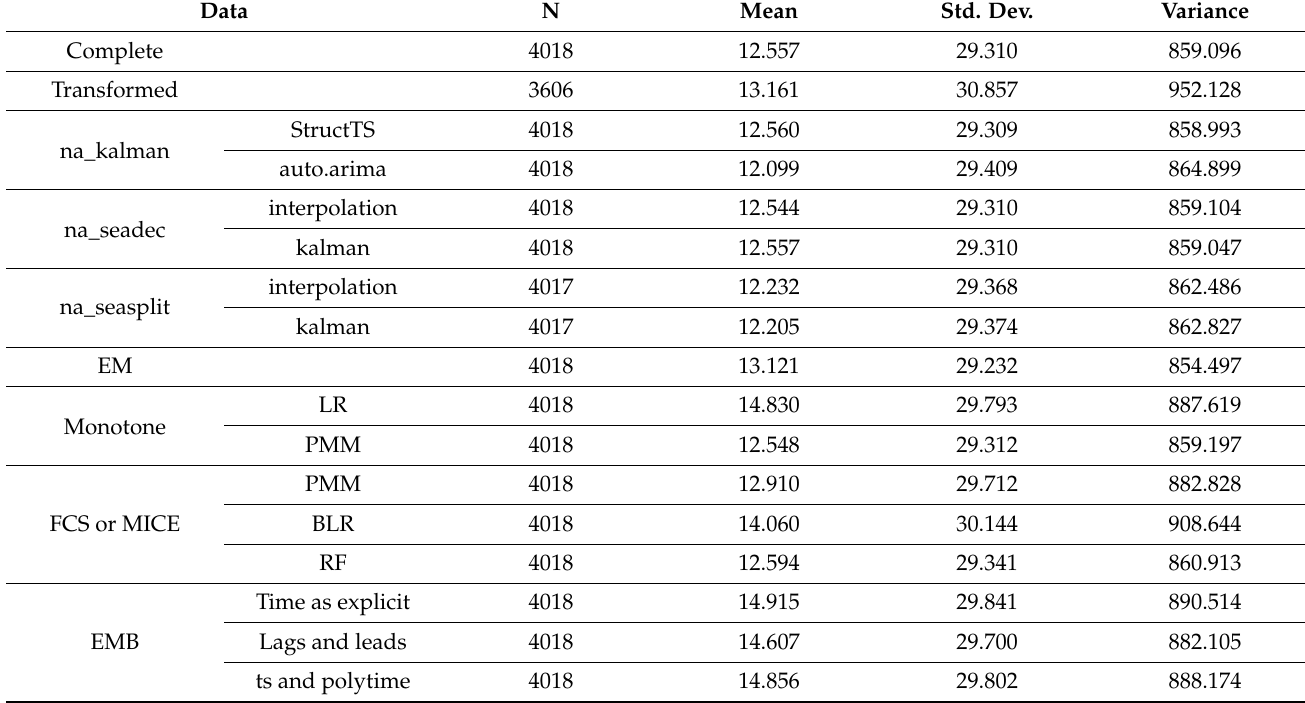
Table 7. Statistical metrics for comparison of imputation algorithms for the Maduwang